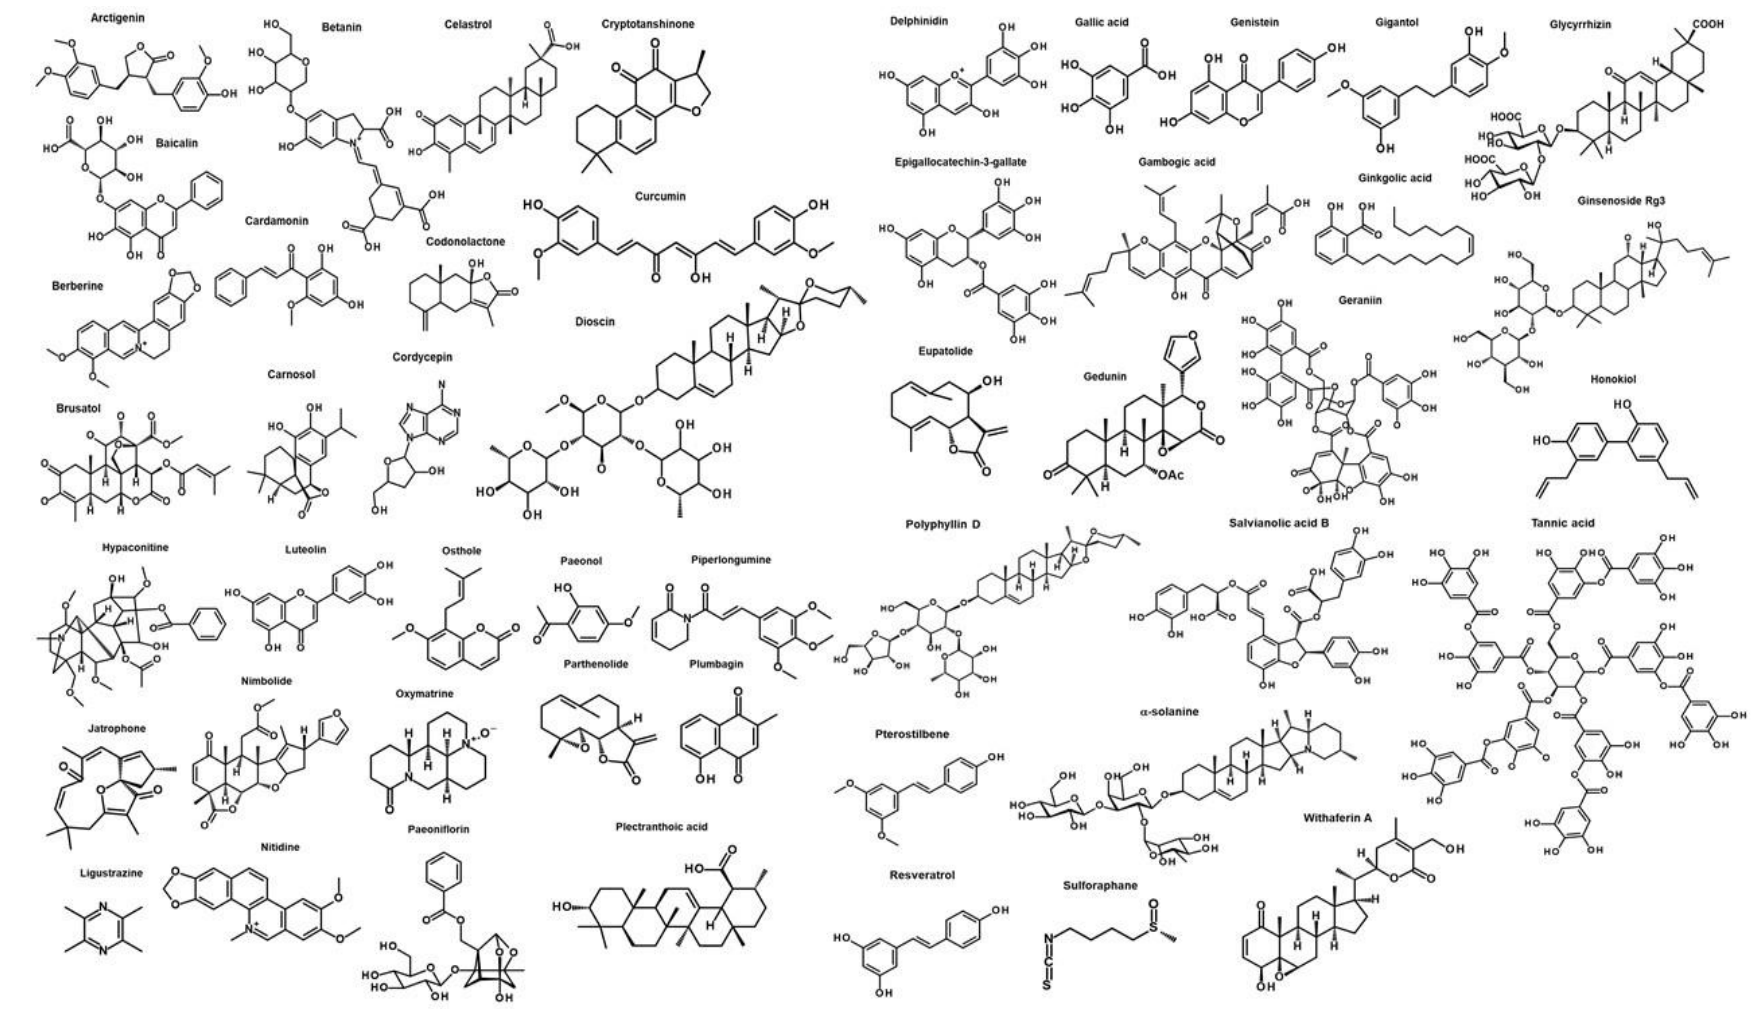
Figure 4. Structure of EMT inhibitors from natural sources.